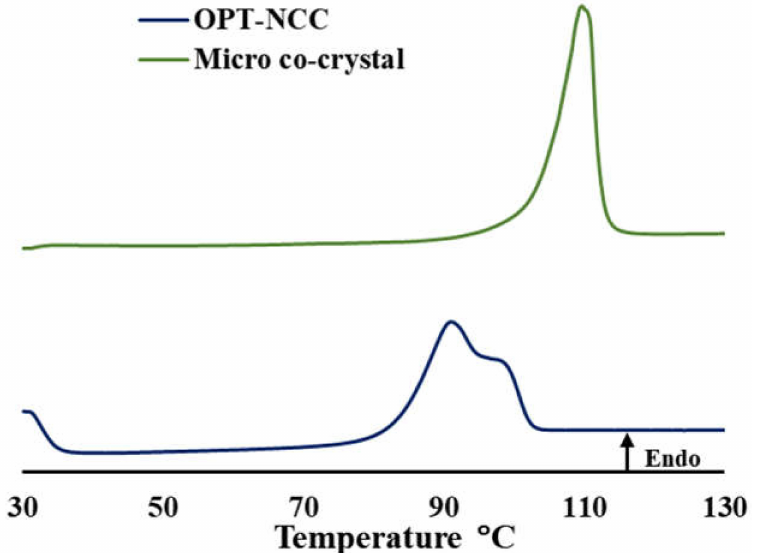
Figure 5. DSC thermogram of micro co-crystals ( green ) [57] and OPT-NCC ( blue